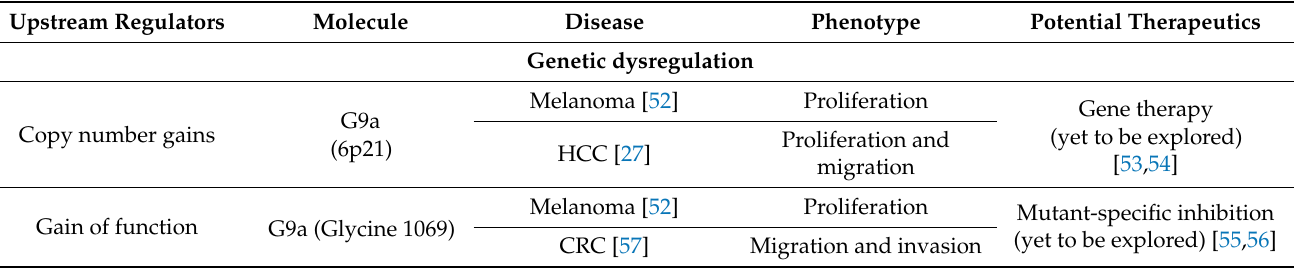
Figure 1. Mechanisms leading to dysregulation of EHMTs. (a) Copy number alterations and mu- tations in EHMT lead to increased expression. ( b ) Transcription factors that bind to the upstream regulatory elements in the EHMT promoter, leading to its expression. ( c ) Specific miRNAs that target and degrade EHMT mRNAs. ( d ) EHMT stability and function are affected by various post- translational modifications. Table 1. EHMT1/2 regulators in distinct cancers and potential therapeutic strategies are